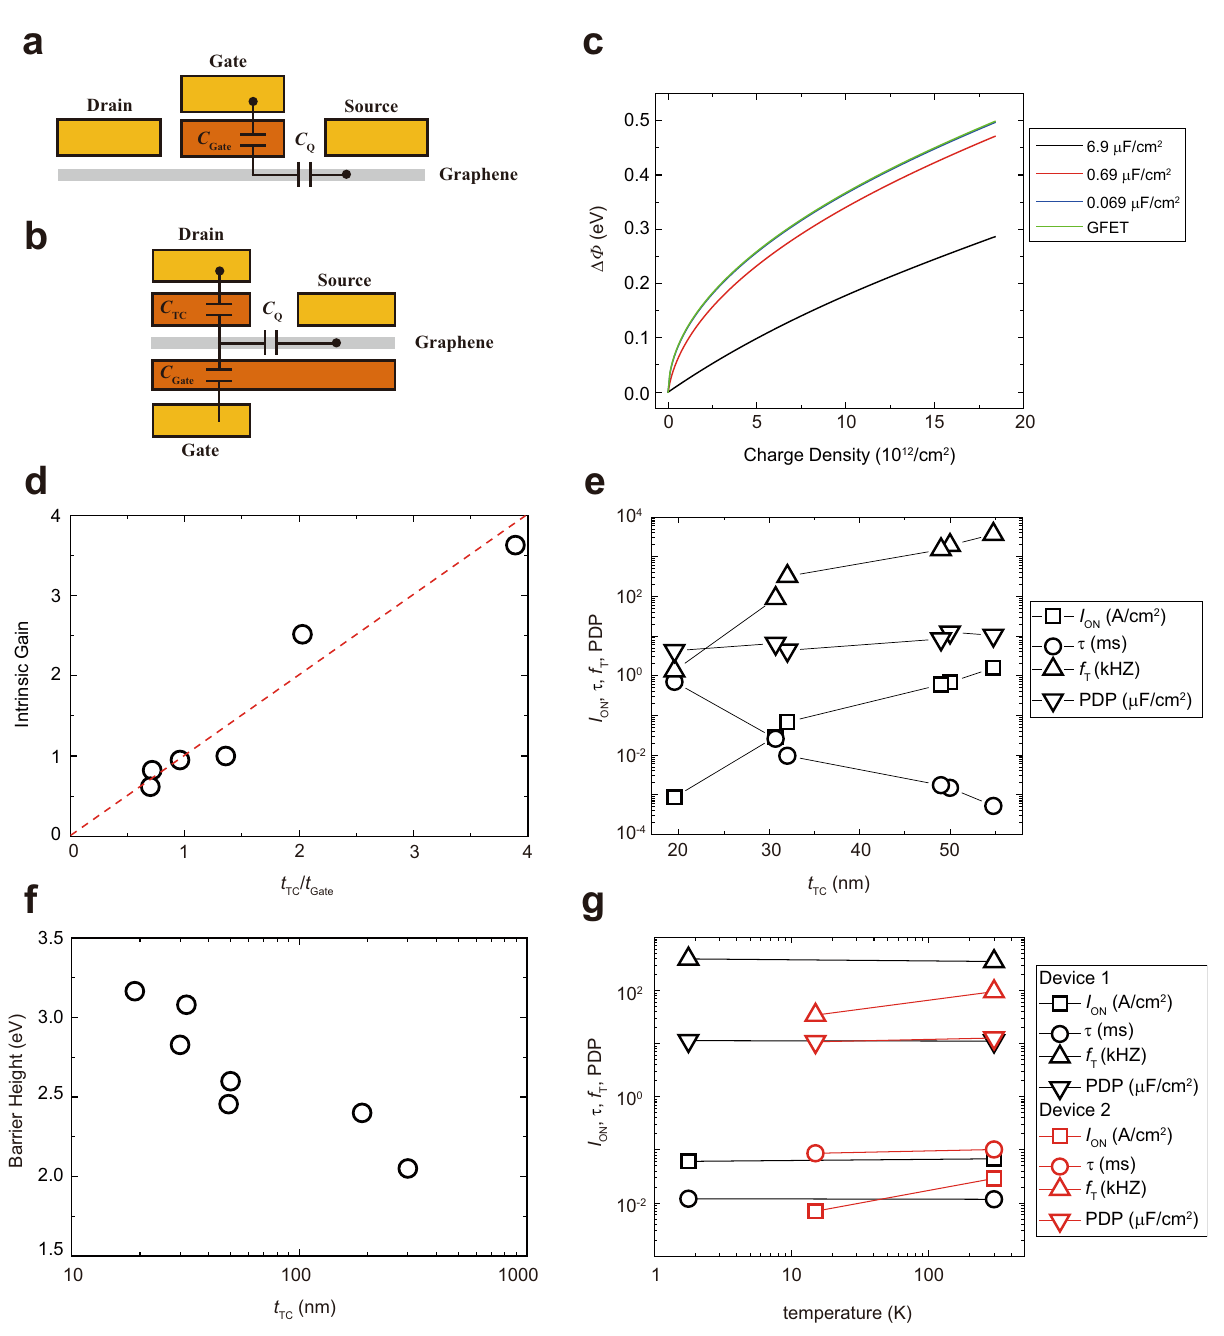
Fig. 3 Capacitive coupling, intrinsic gain, and device performances. Capacitive coupling of a GFET and b FEB. c Work function shift by varying the C total = C TC + C Gate . C total = 6.9 μ F/cm 2 when t Gate = 1 nm and t TC = 1 nm; C total = 0.69 μ F/cm 2 when t Gate = 10 nm and t TC = 10 nm; and C total = 0.069 μ F/cm 2 when t Gate = 100 nm and t TC = 100 nm. The work function modulation of GFET is the upper limit of that of the FEB. d Intrinsic gain ( g m / g ds ) by varying the t TC / t Gate . The intrinsic gain is proportional to the t TC / t Gate (the red dotted line is for guidance). e Device performances when t TC is 19.5, 30.7, 32, 49, 50, and 54.8 nm, and t Gate is 27.8, 42.8, 33, 36, 52, and 54.4 nm, respectively. I ON , 1/ τ , f T , and PDP increase with t TC . They increase to ~1000 times as t TC increases by ~35 nm, except for PDP. f Field-emission barrier height by varying t TC , extracted by single-emitter approximation. The barrier height between graphene ’ s Dirac point and the conduction band decreases as t TC increases. It decreases by 1.2 eV, as t TC increases from 19.5 to 301 nm. g